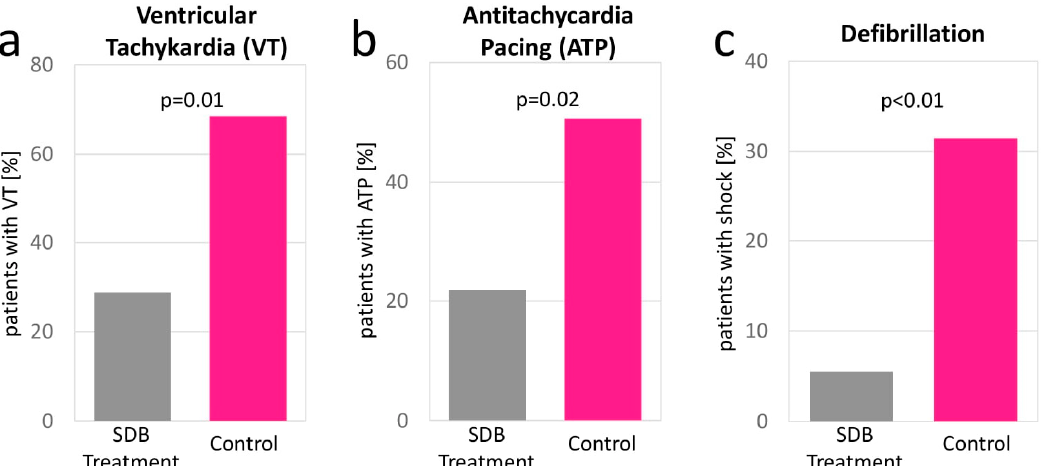
Figure 3. At 1-year follow-up, a significantly lower rate of ventricular tachycardia events ( a ) antitachycardia pacing ( b ) and defibrillation ( c ) was observed in the SDB treatment group.